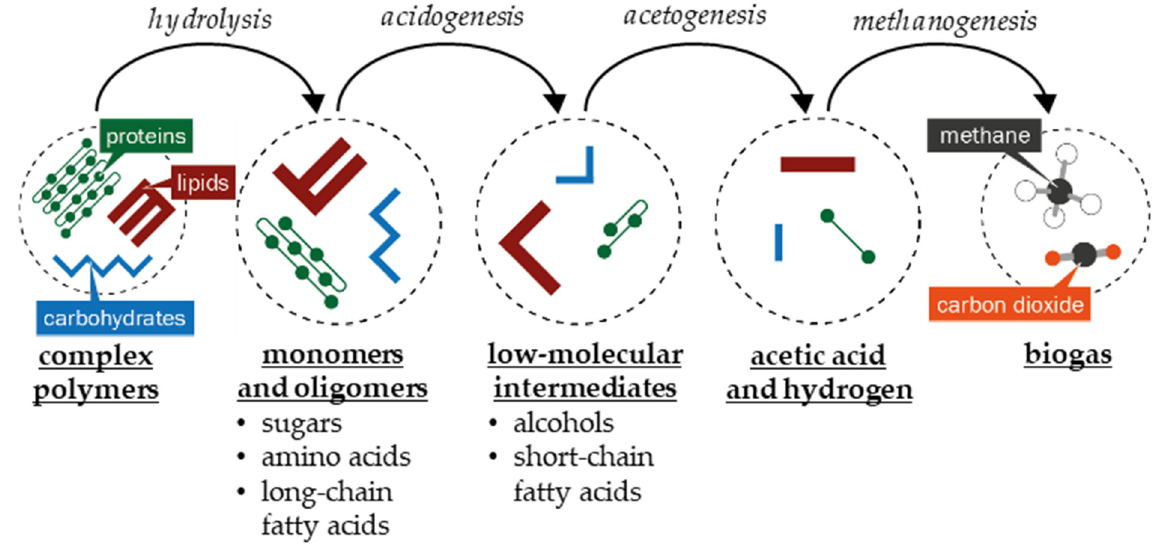
Figure 1. Sequence of decomposition products from the four steps of biogas production: hydrolysis, acidogenesis, acetogenesis, and methanation [23].